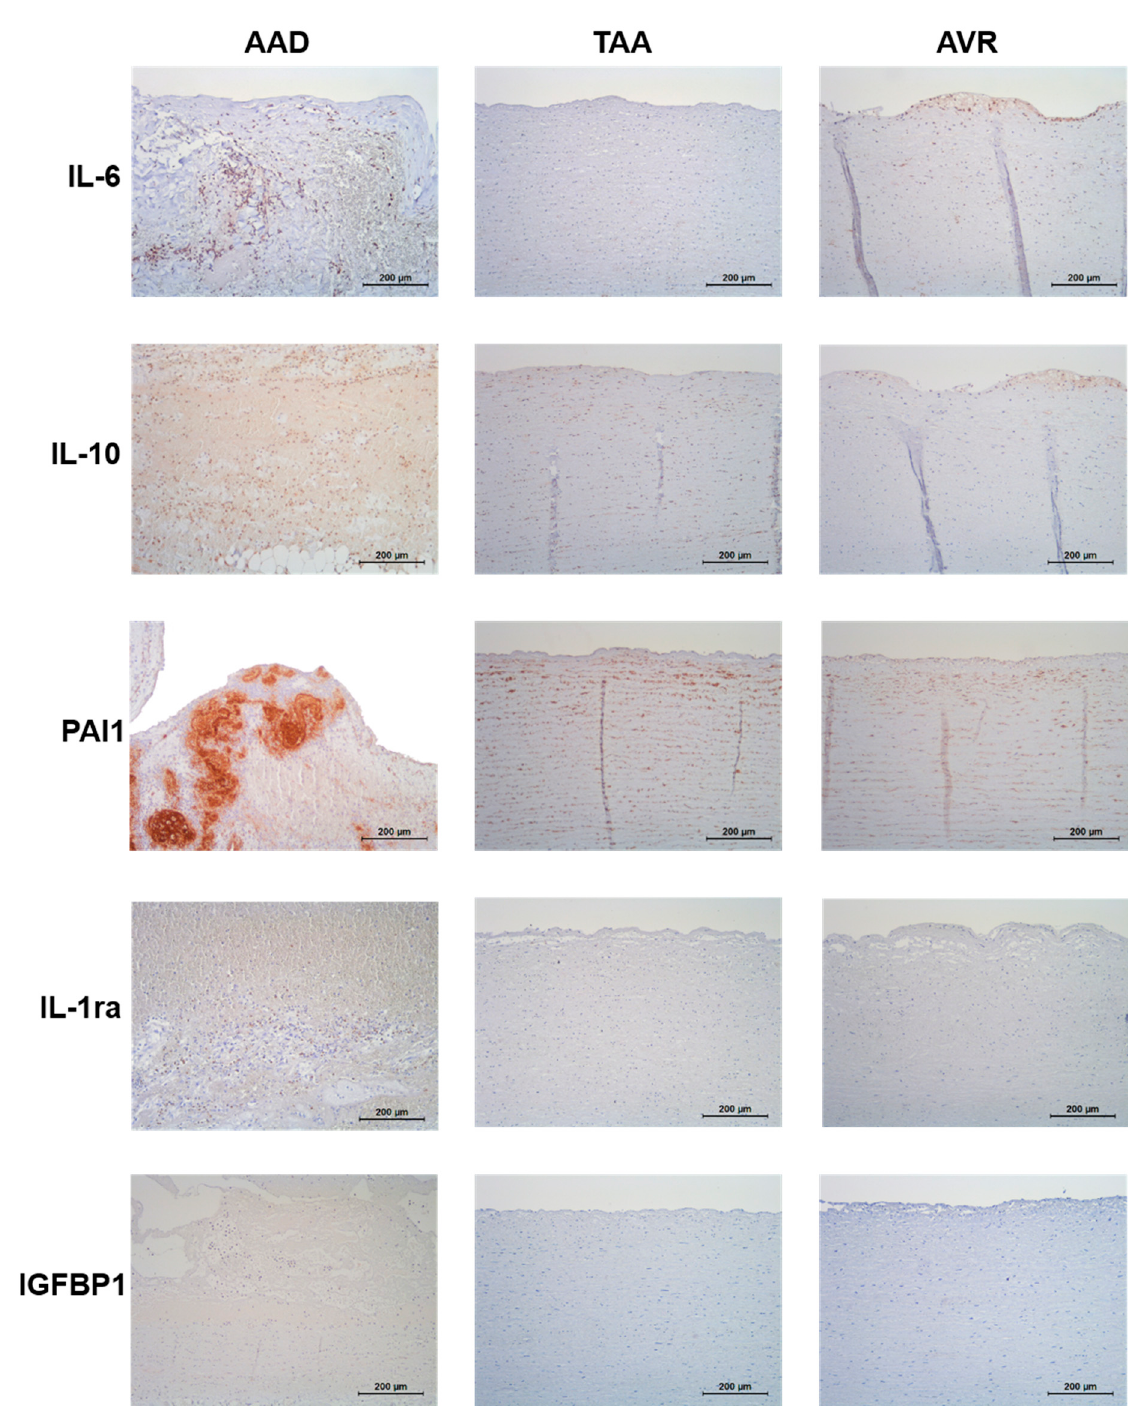
Figure 2. Immunohistochemical staining of IL-6, IL-10, PAI1, IL-1ra, and IGFBP1 in the aortic tissue of patients with AAD, TAA, and AVR.